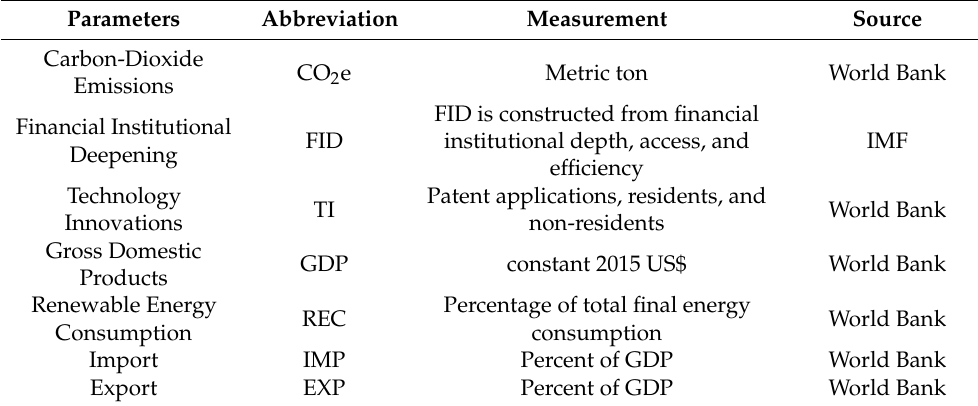
Table 2. Represents the descriptive statistics of the parameters.